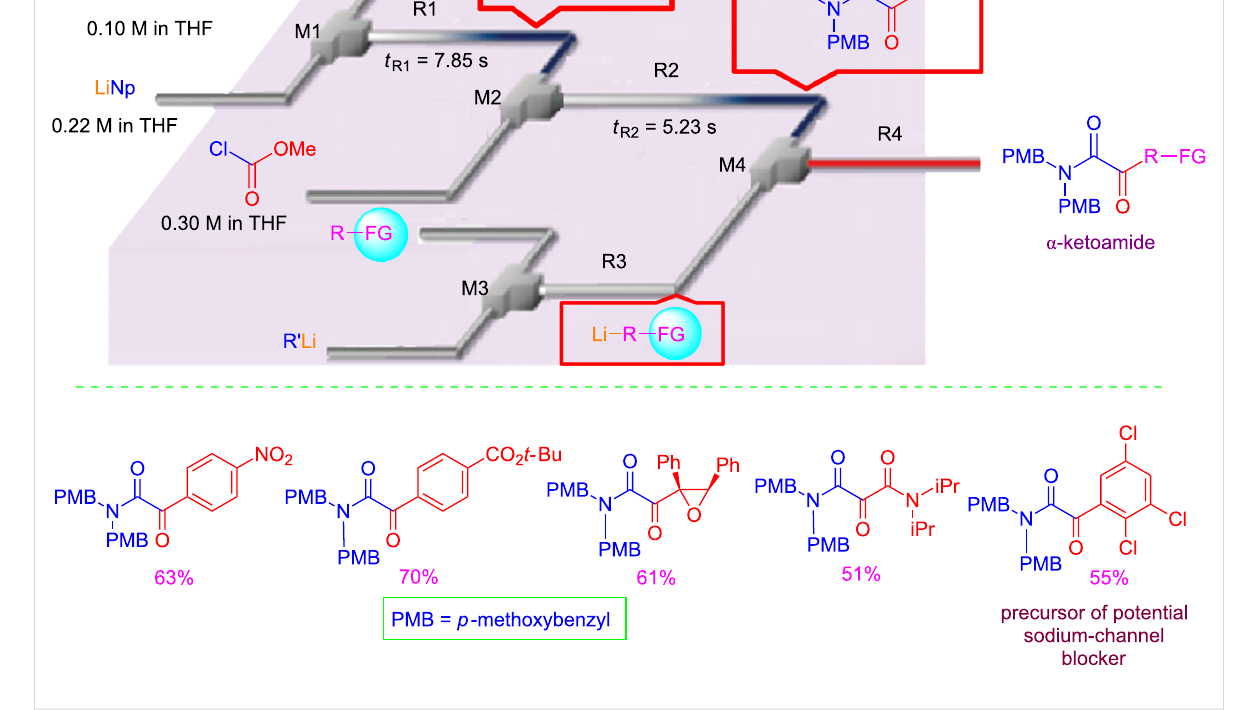
Scheme 2: Flow synthesis of functionalized α -ketoamides.